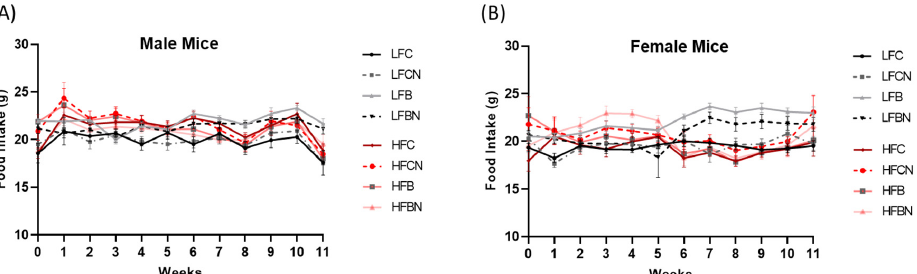
Figure 2. Weekly food consumption in ( A ) male and ( B ) female mice throughout the dietary intervention. LFC, low fat casein; LFCN, low fat casein pH enhanced; LFB, low fat beef; LFBN, low fat beef pH enhanced; HFC, high fat casein; HFCN, high fat casein pH enhanced; HFB, high fat beef; HFBN, high fat beef pH enhanced. p < 0.05; n = 8–10.